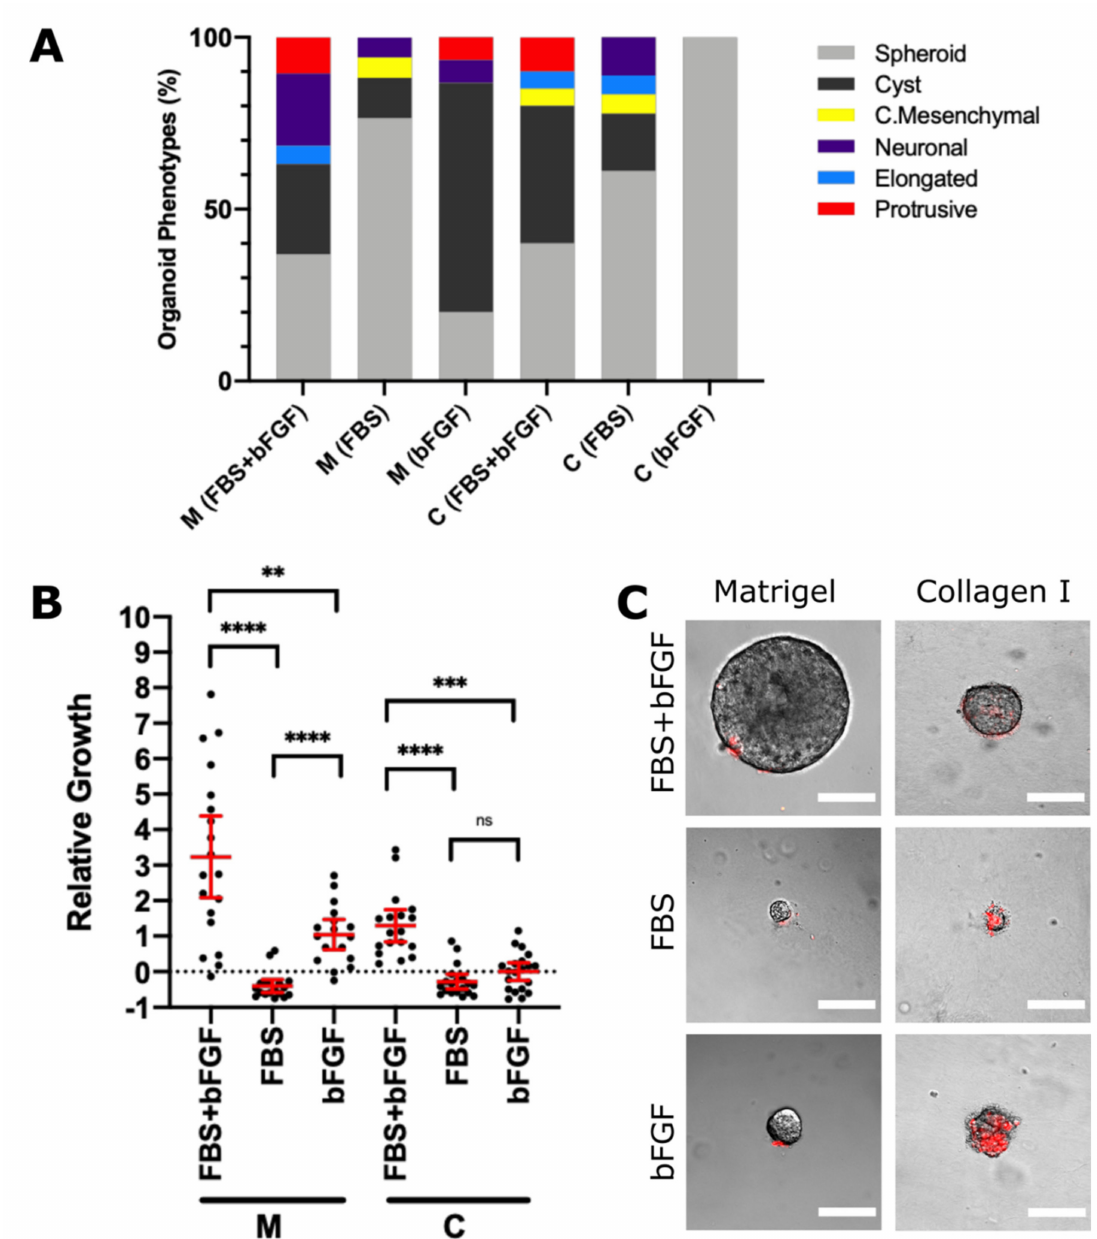
Figure 3. The invasion and growth of NB organoids is dependent on soluble factors in the microenvironment. ( A ) Felix-PDX organoids were cultured in Matrigel or collagen in the presence of FBS + bFGF, FBS or bFGF alone and corresponding bar charts representing phenotype classifications. ( B ) The relative growth of these organoids was calculated by dividing the difference in area between 0 h and 96 h by the area at 0 h. ( C ) Representative images of EHD staining (dead cells: red) of organoids at 120 h. Each dot represents the relative growth of one organoid (Matrigel: n = 19 in FBS/bFGF, n = 17 in FBS, n = 15 in bFGF. Collagen: n = 20 in FBS/bFGF, n = 17 in FBS, n = 14 in bFGF). Error bars indicate the mean ± 95% confidence interval. Asterisks indicate statistical significance obtained using Brown–Forsythe ANOVA with T3 Dunnett post-hoc test (ns, not significant, * p < 0.05, ** p < 0.01, *** p < 0.001, **** p < 0.0001). Scale bars = 100 µ